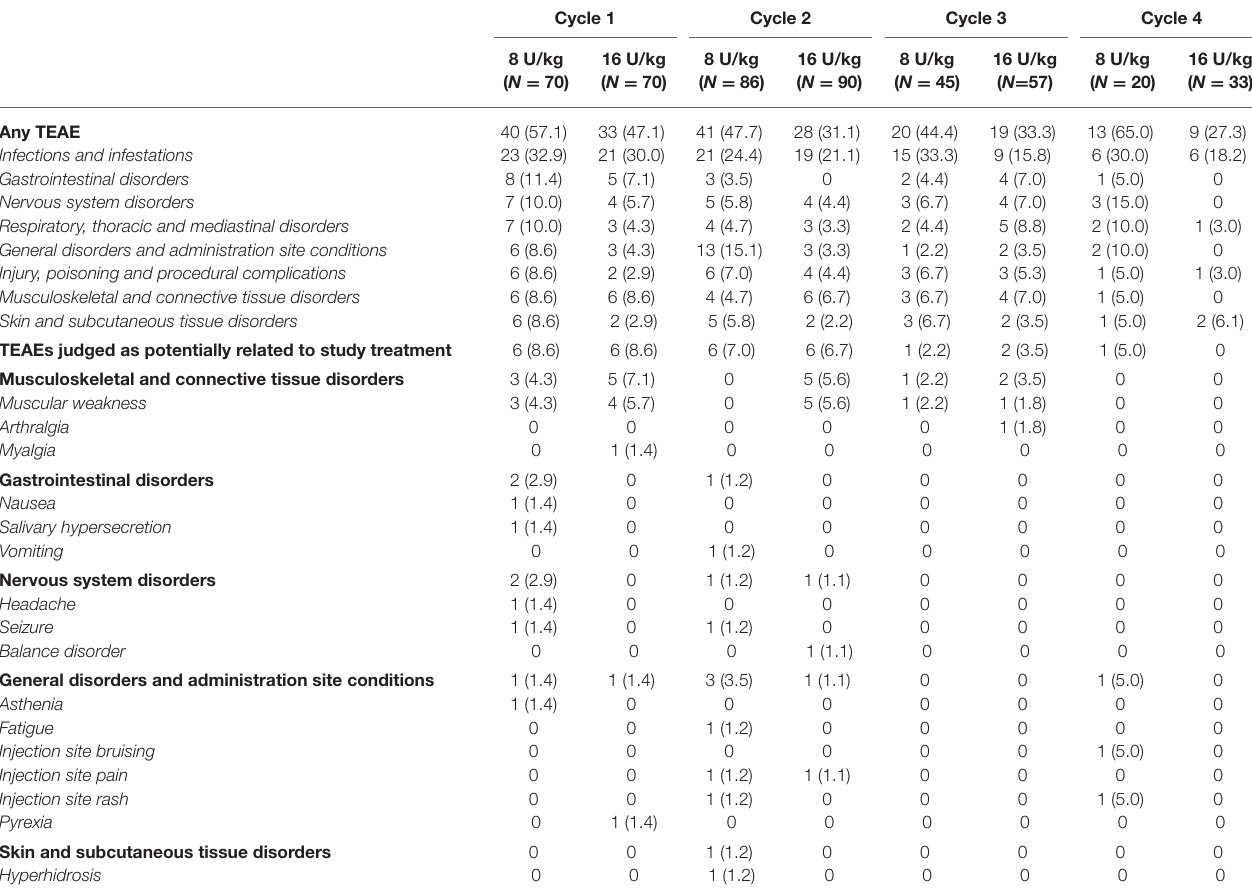
TABLE 4 | Treatment emergent adverse events.